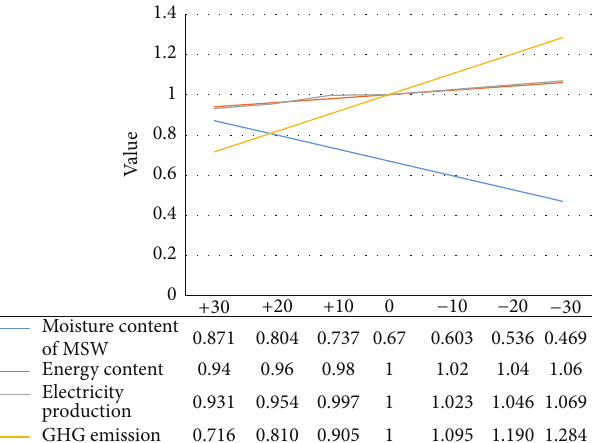
Figure 10: Sensitivity analysis of MSW moisture contents on WtE performance and GHG